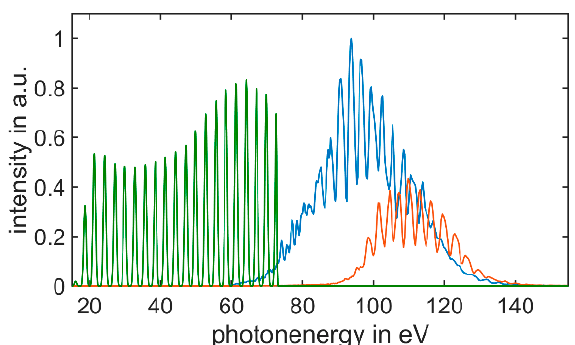
Figure 2. XUV spectrum of the attosecond beamline of the Relativistic Attosecond Physics Laboratory at Umeå University with 3 × 150 nm Zr filters (blue), 2 × 150 nm Zr + 1 × 100 nm Pd filters (red), and 2 × 500 nm Al filters (green). The spectrum with the Al filters was simulated using the transmission of the Al filters, and a plateau odd harmonic spectrum as the spectrometer was operating in a shorter wavelength range. The area below the Al spectrum was scaled to be 38% of the area below the Zr spectrum, corresponding to the energy in this region.